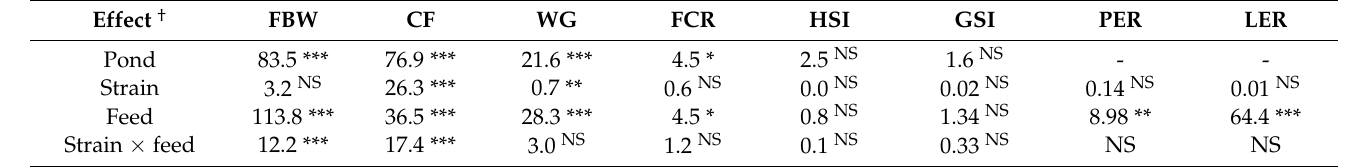
Table 2. Experiment 1 in Bukavu, eastern highlands DR Congo— F -values of fixed effects for final body weight (FBW), condition factor (CF), initial body weight (IBW), weight gain (WG), feed conversion ratio (FCR), hepato-somatic index (HSI), gonado-somatic index (GSI), protein efficiency ratio (PER), and lipid efficiency ratio (LER). FBW and CF calculated using data from individual fish, while the other parameters based on hapa data. All parameters were analyzed using Equation